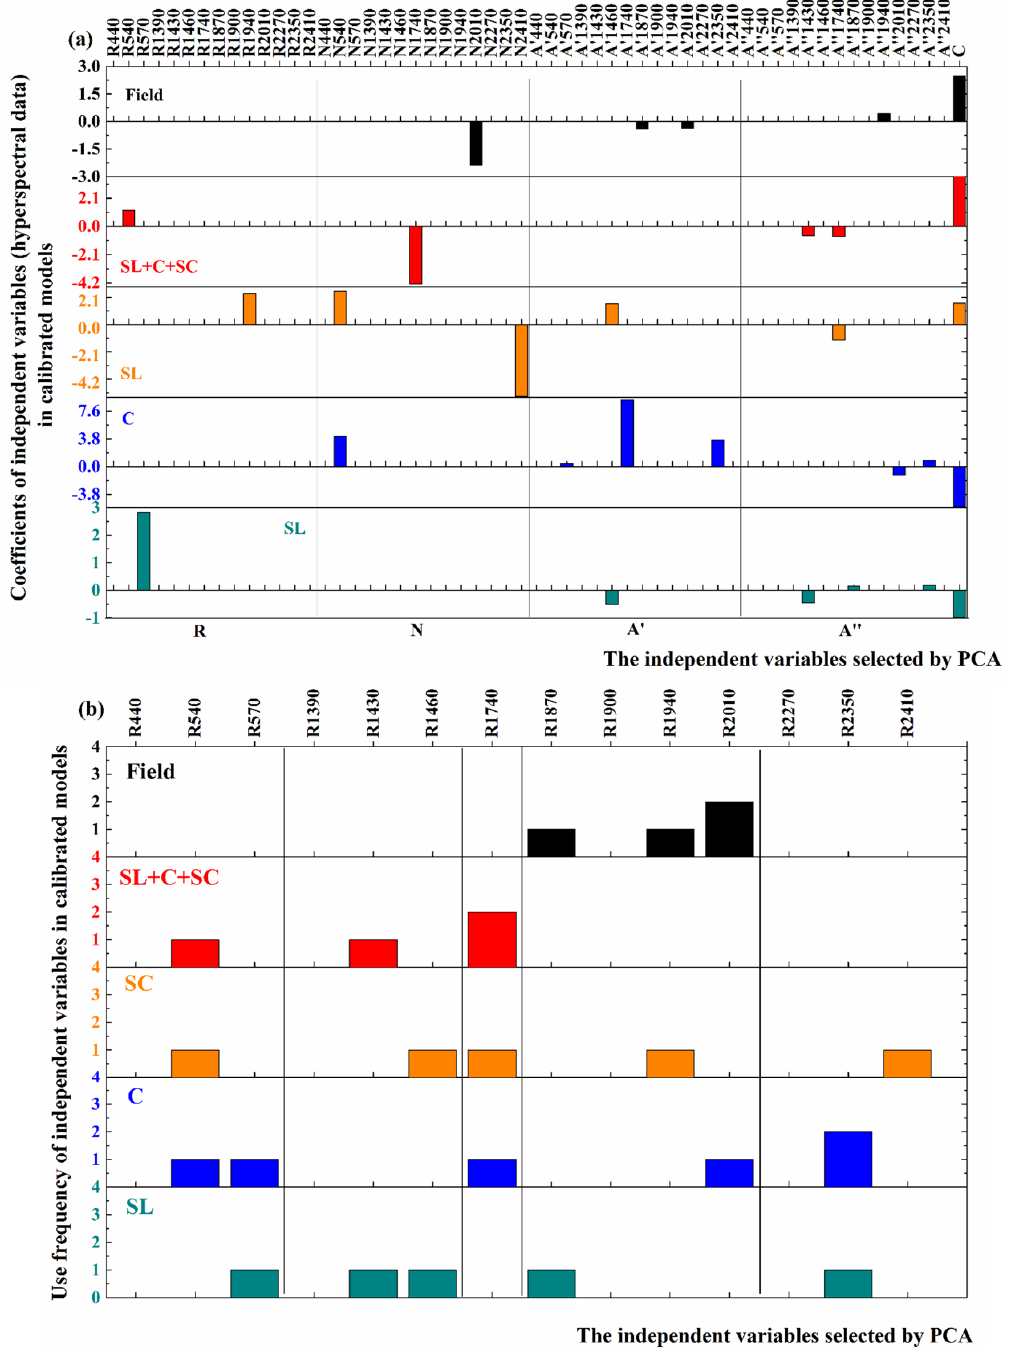
Figure 6. Bar graphs for ( a ) coefficients of M_SSC models for soil salt concentration, where C (last variable on the X-axis in ( a ) is a constant in the models; and ( b ) use frequency of the independent variables/wavebands in the calibration models.